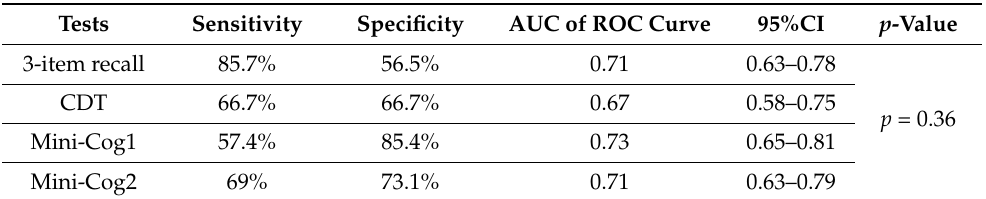
Table 2. Comparison of the overall performance of the three-item recall test, CDT, Mini-Cog1, and Mini-Cog2.